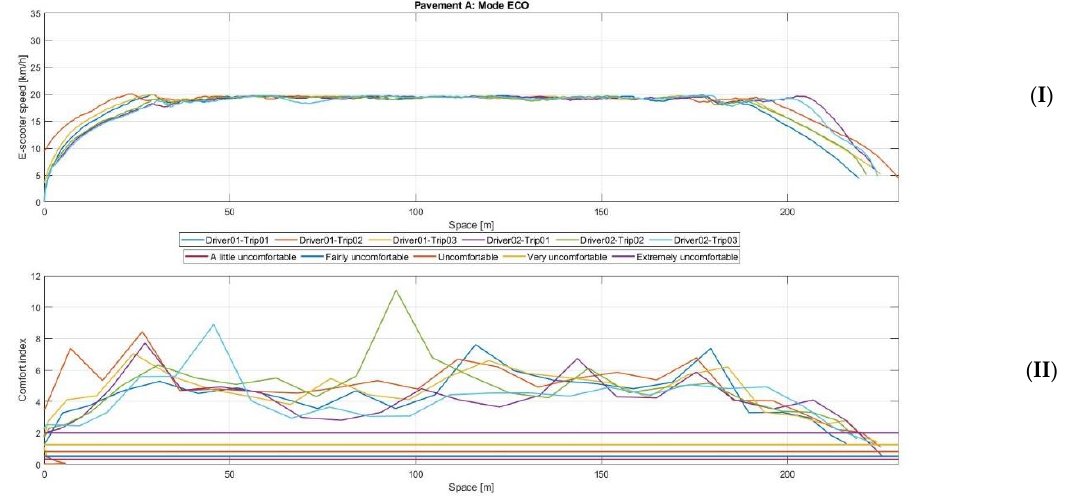
Figure 7. Speed profile ( I ) and comfort index ( II ) for 2 s RMS, pavement A, and mode ECO.